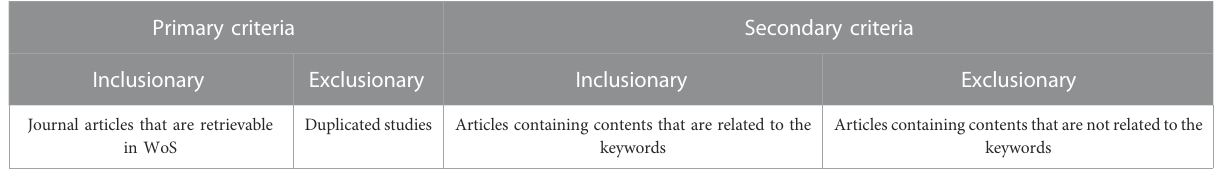
TABLE 1 Inclusion criteria and exclusion criteria.